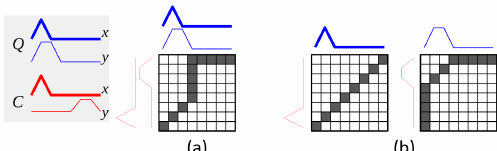
Figure 6. Dynamic Time Warping (DTW) for multi-dimensional time series: dependent ( a ) and independent ( b ) DTW. The former consists of computing the DTW similarity path of both dimensions (axis) at the same time. The latter is much simpler; normal DTW is computed separately on each dimension and their results added